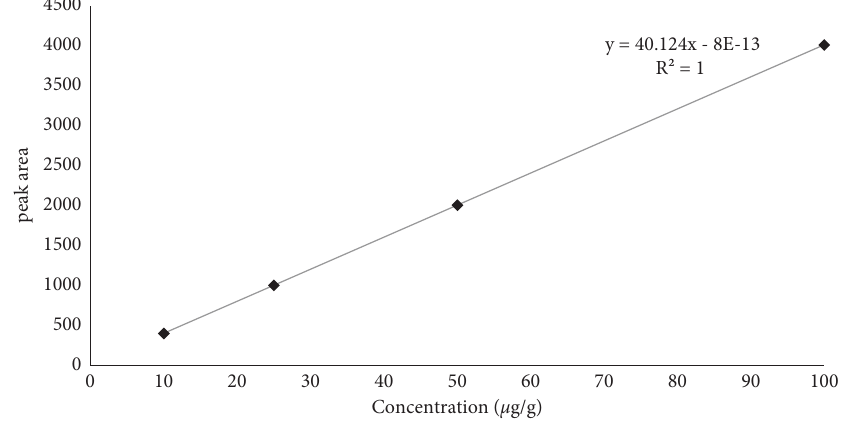
Figure 1: Ergosterol calibration curve.